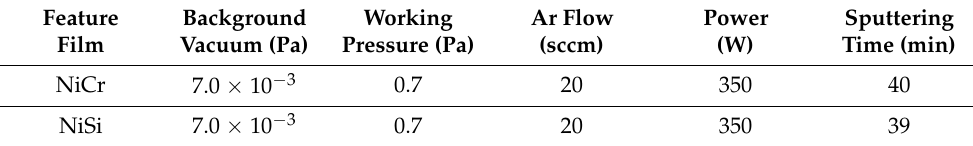
Table 2. Preparation technological parameters of NiCr/NiSi thin film.